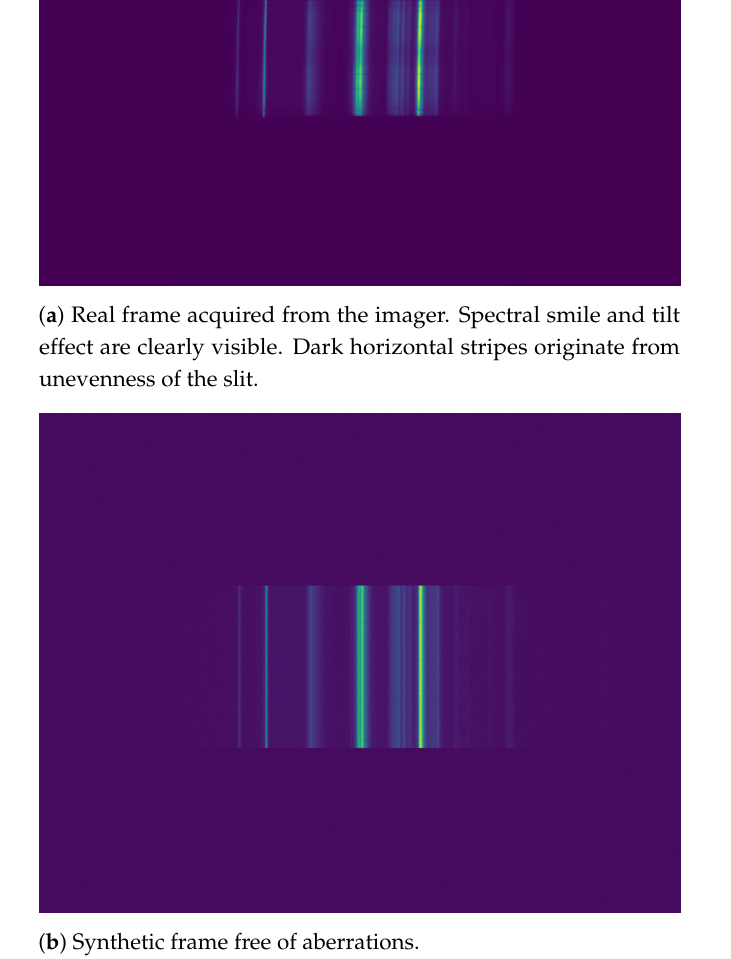
Figure 2. Real frame with aberrations and ideal synthetic frame compared side by side. The used imaging target was a fluorescence